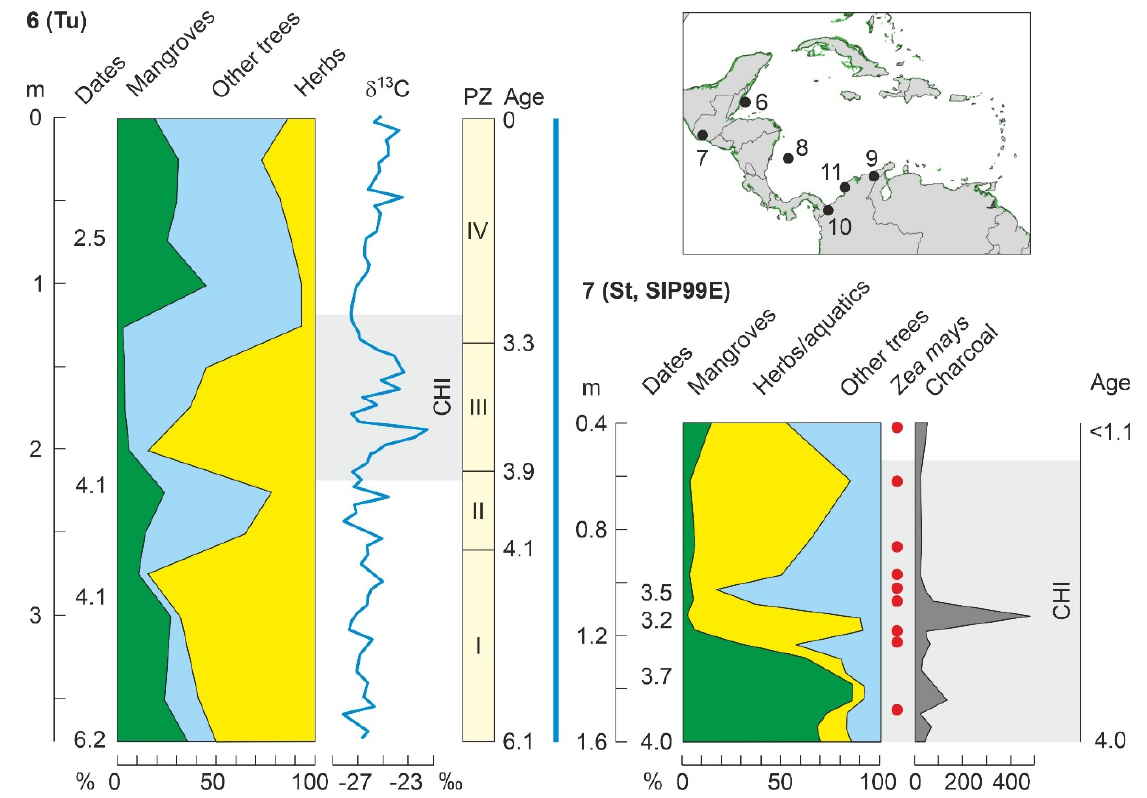
Figure 19. Summary pollen diagrams from Mesoamerican sites showing mangrove reductions around the CHI climatic event (gray band). The occurrence of pollen from cultivated plants is indicated by red dots (Cb, Cucurbitaceae; Zm , Zea mays ). All dates (calibrated from 14 C dates) and ages (interpolated/extrapolated from age-depth models) are in cal kyr BP and have been taken from the original references. Charcoal is represented in concentration units (particles/mL of sediment). PZ, pollen zones. Redrawn and composed from Refs.